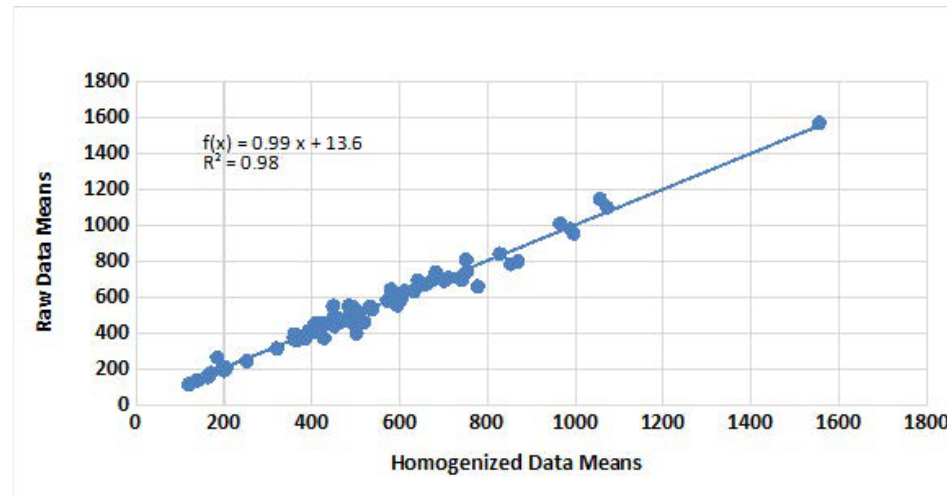
Figure 8. Correlation between annual means of raw and homogenized